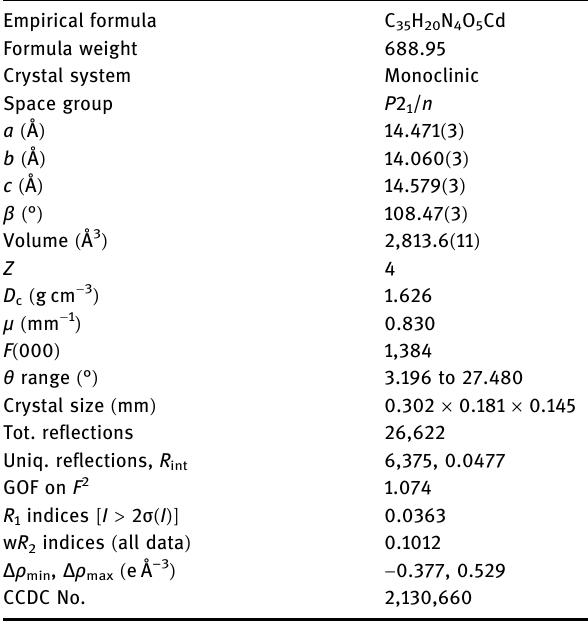
Table 2: Crystalline data and re fi nement parameters for complex